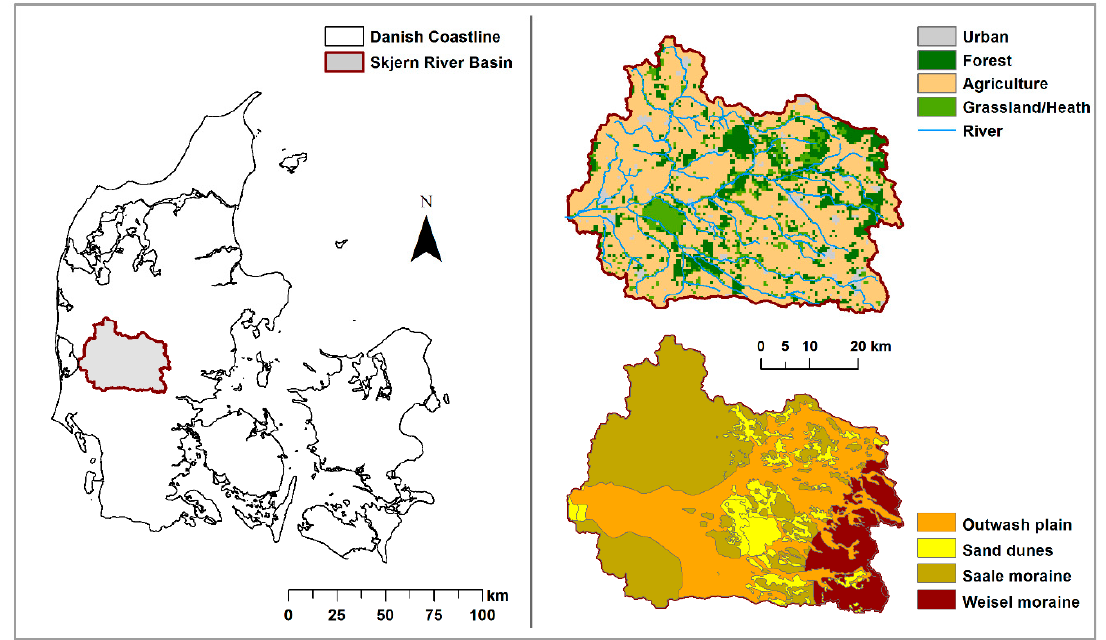
Figure 1. Map of Denmark and Skjern River Basin characteristics.